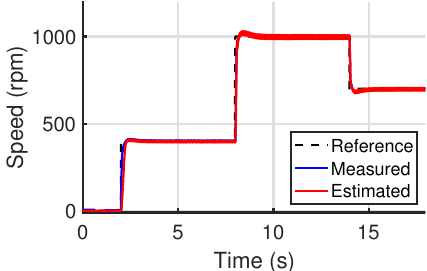
Figure 22. Experimental results of SMO at variable speed.